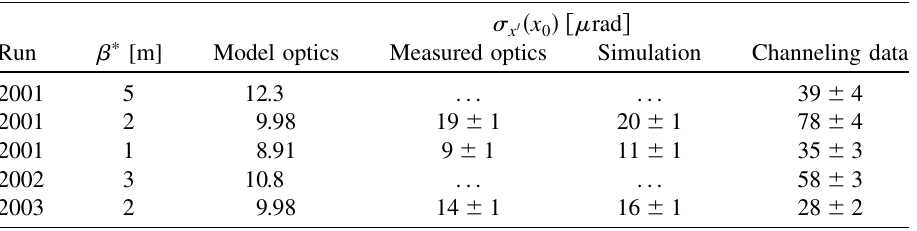
(cid:2) x (cid:3) . x 0 0